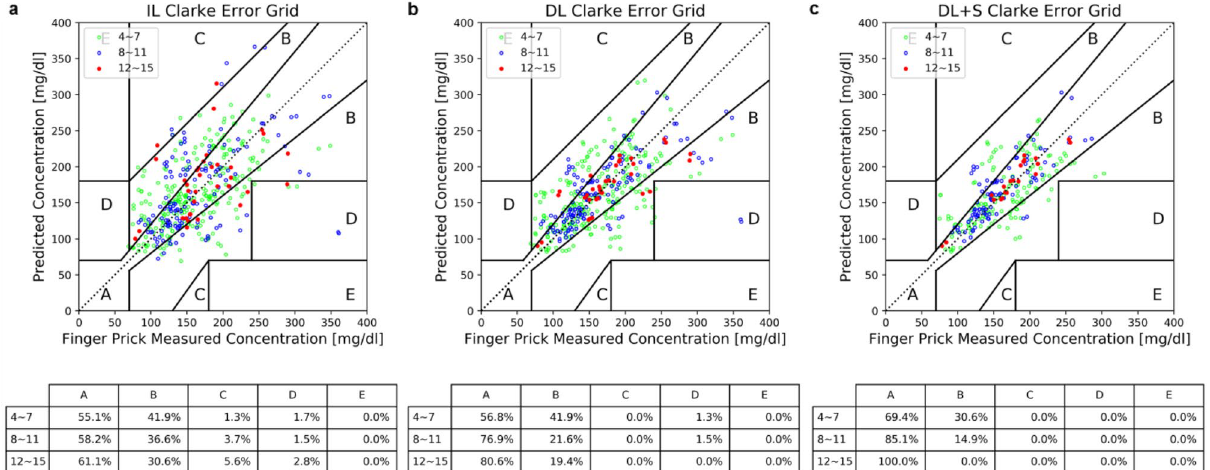
Figure 3. Clarke Error Grid (CEG) plots of model predictions: ( a ) IL. ( b ) DL. ( c ) DL + S. The data points are grouped into three categories: green symbols are results of 4th to 7th rounds, blue symbols are results of 8th to 11th rounds, and red symbols are results of 12th to 15th rounds, respectively. The table below each figure lists the proportion of data points found in each zone of the CEG. For DL and DL + S, all data points of rounds 12 to 15 are found in zone A and B.